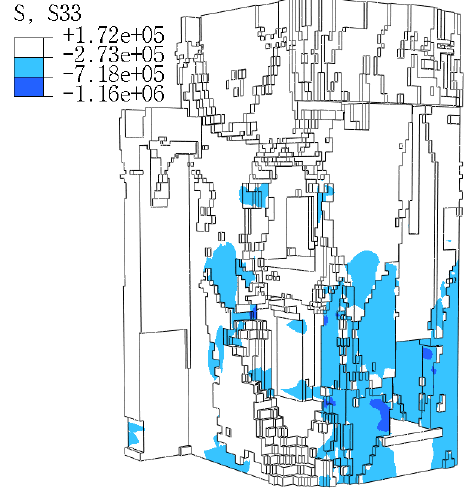
Figure 10. Vertical stress contour plot